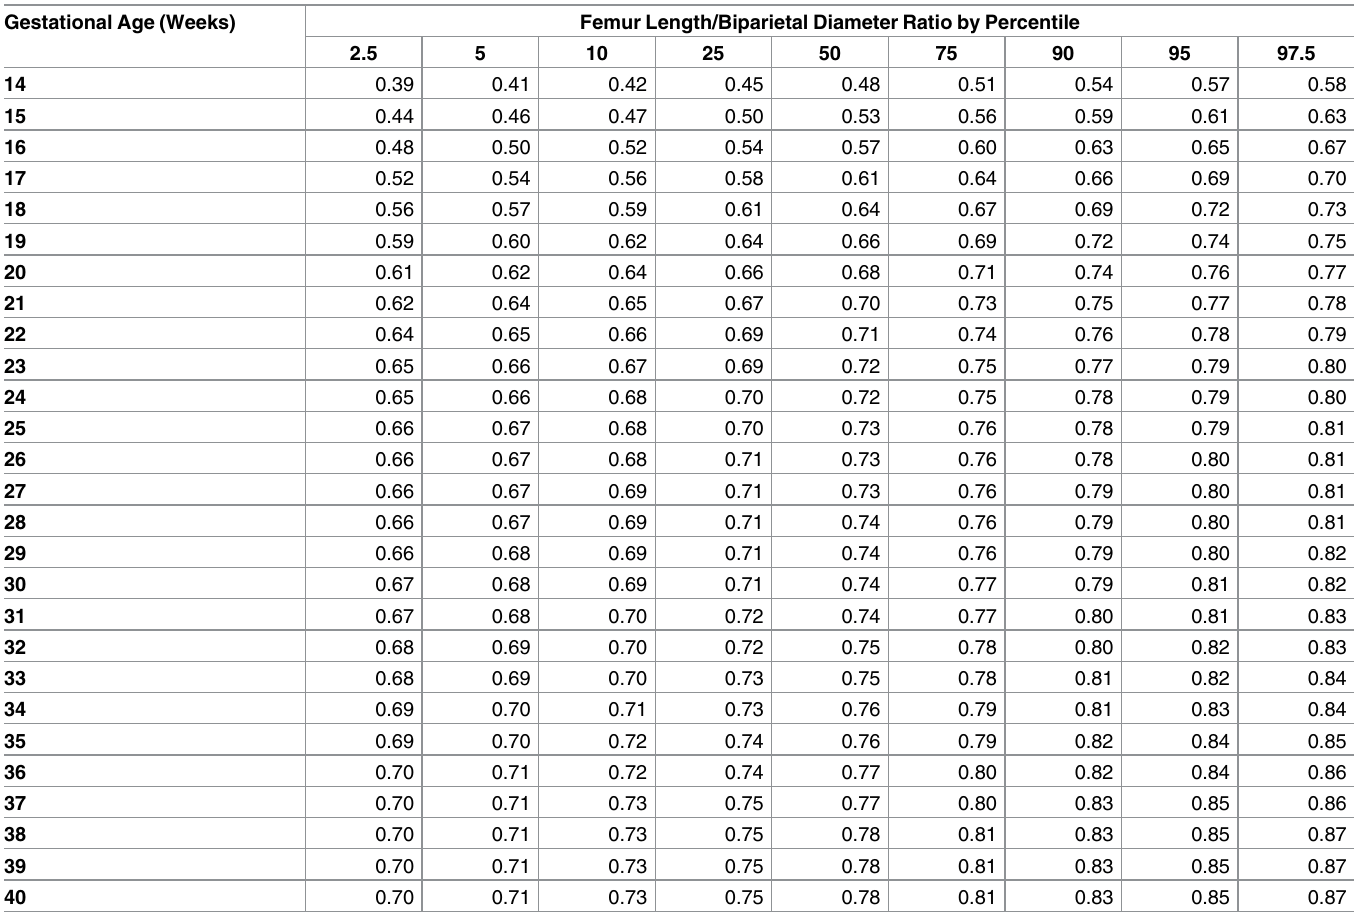
Table 12. Growth chart for fetal femur length/head circumference ratio. Gestational Age